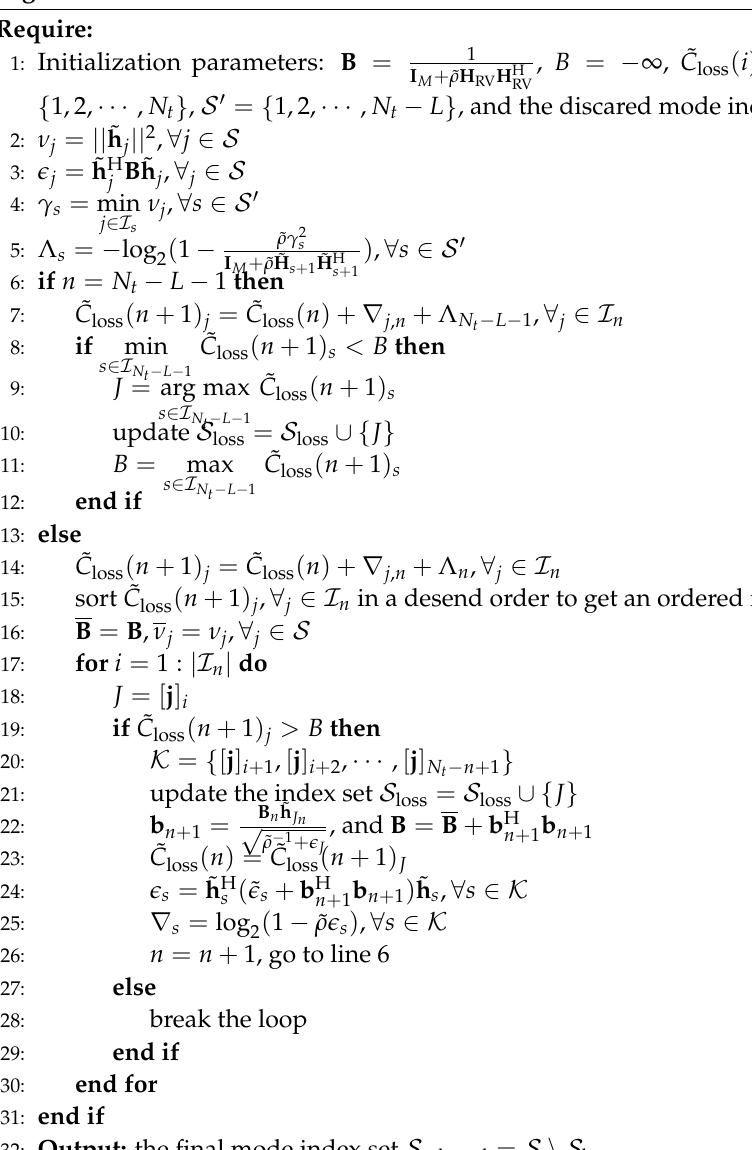
Algorithm 1 The BBS-MS